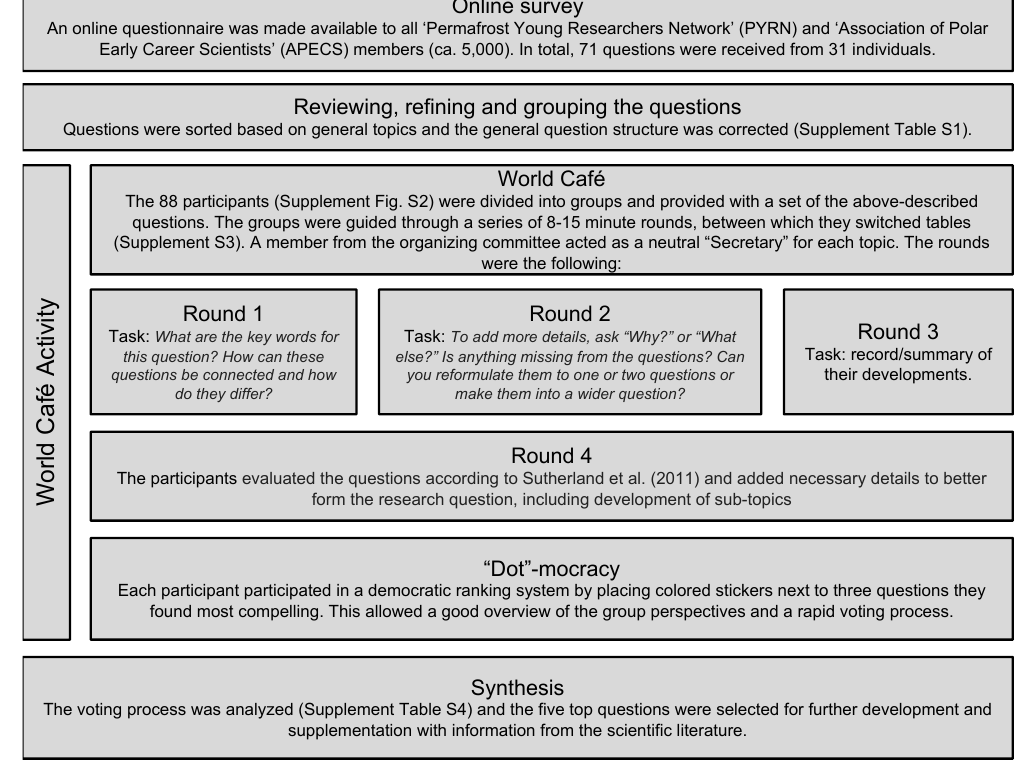
Figure 1. Flowchart of the process used to develop and refine future research questions. Questions were initially developed via an online survey. After some refinement, the process continued with an on-site “World Café” (Brown and Isaacs, 2001) workshop. Questions asked throughout the World Café enabled participants via group discussion to consider structure, breadth, and depth of the questions (Sutherland et al., 2011). Workshop participants (Fig. S2 in the Supplement) voted to identify the questions they believed to be the most compelling as a final step in the on-site activities. Based on votes, five questions were selected for further development and dissemination. The collaborative nature of the activities, coupled with substantial interest from all participating ECRs, enabled high levels of participation and thoughtful discussions about the future of permafrost research. Detailed workshop guidelines are given in Supplement